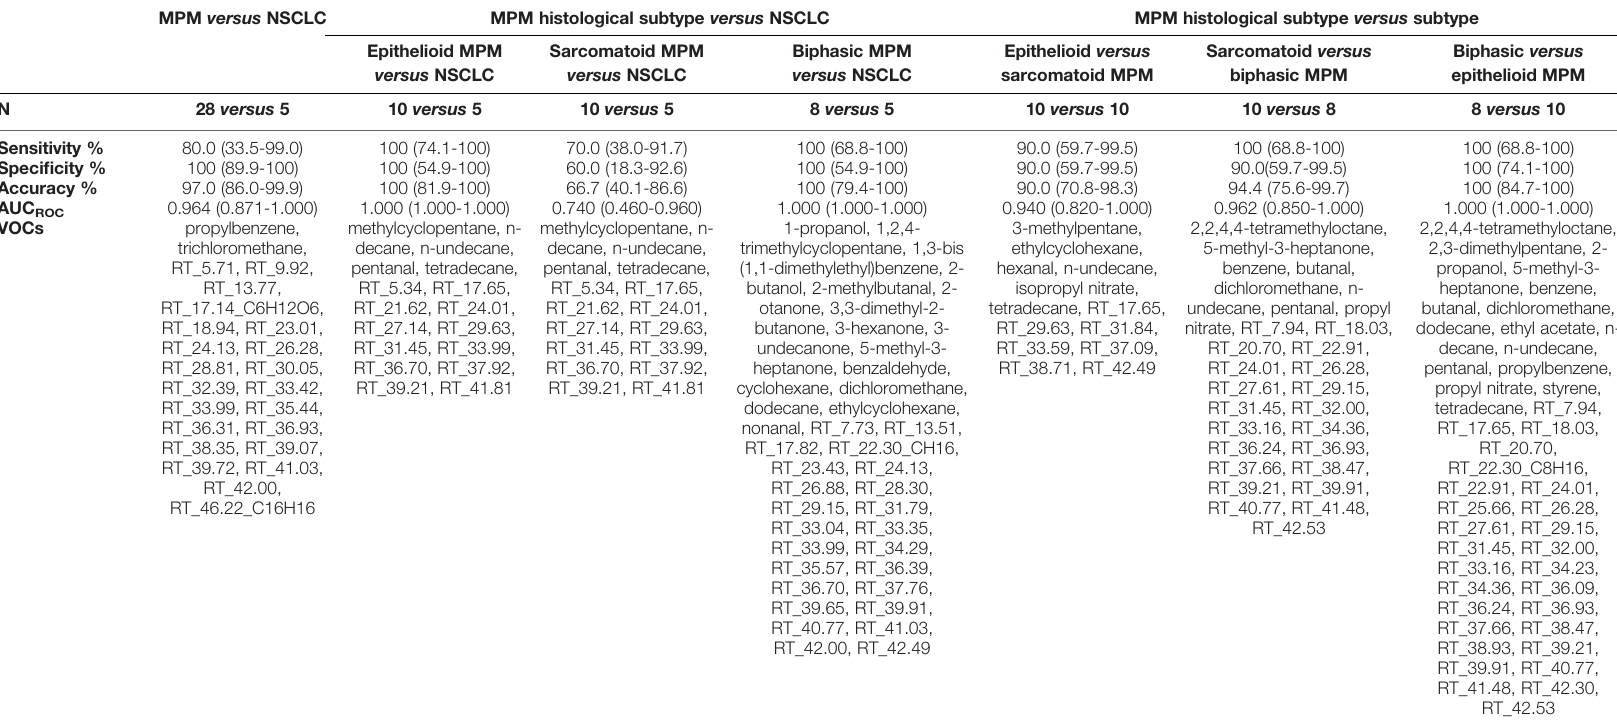
TABLE 2 | Characteristics of the discrimination models created with least absolute shrinkage and selection operator (lasso) regression and their 95% con fi dence